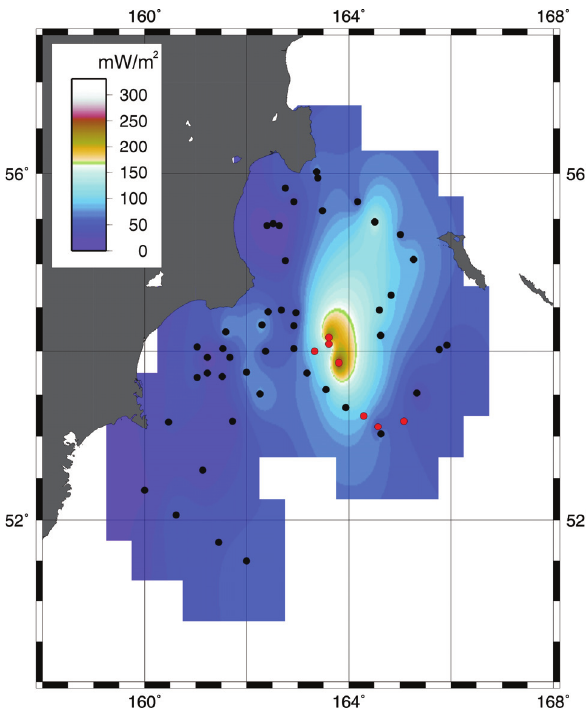
Fig. 9. Summary of all available heat flow values for the area east of Kamchatka and south of the Kurile-Kamchatka island arc system. Data are compiled from measurements during cruise SO201-2 and values provided by Smirnov and Sugrobov (1982) and Smirnov et al.